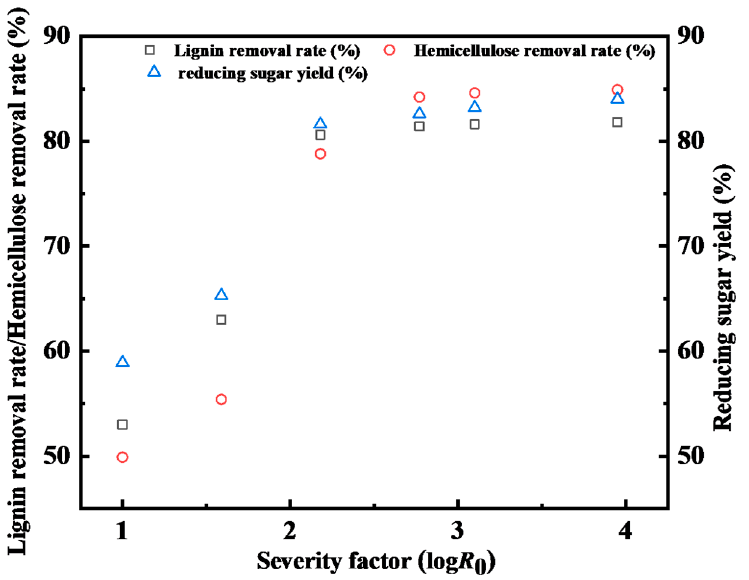
Figure 9. Correlation of lignin removal, hemicellulose removal, and reducing sugar yields with severity factor (log R 0 ).